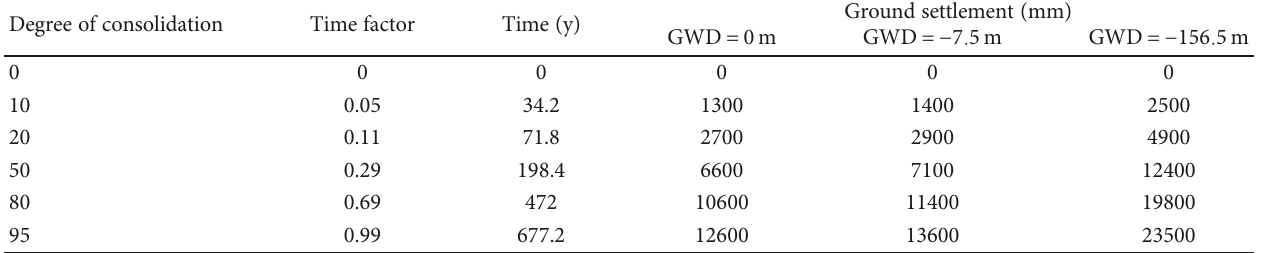
Table 5: Time e ff ect of ground settlement under di ff erent groundwater levels.